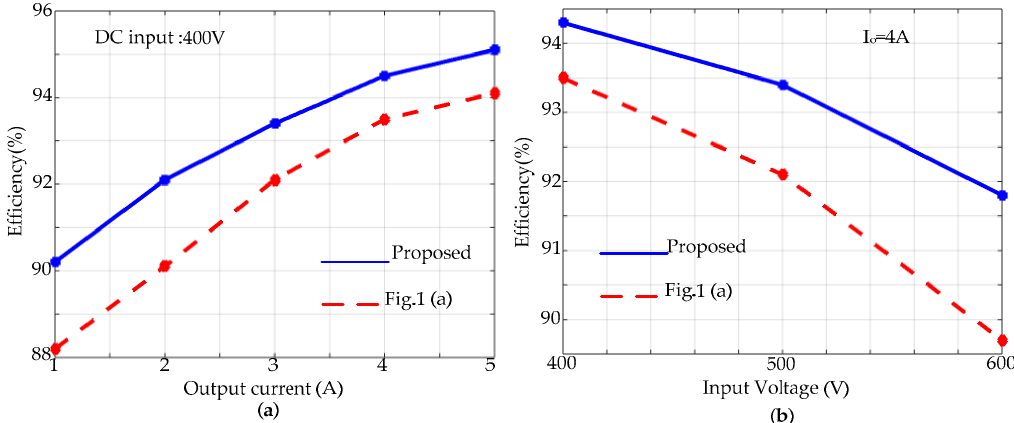
Figure 11. Waveform of v Q3 , i Q3 and v GSQ3 .